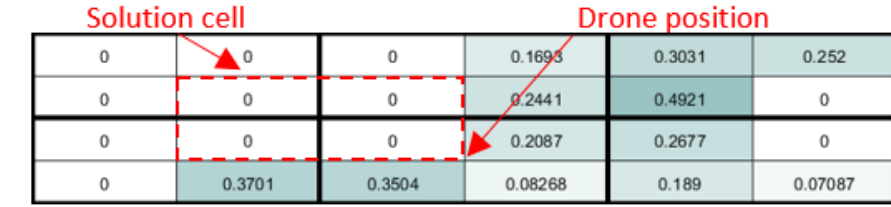
Figure 14. Subdivision for the grid Box G for the third obstacle.